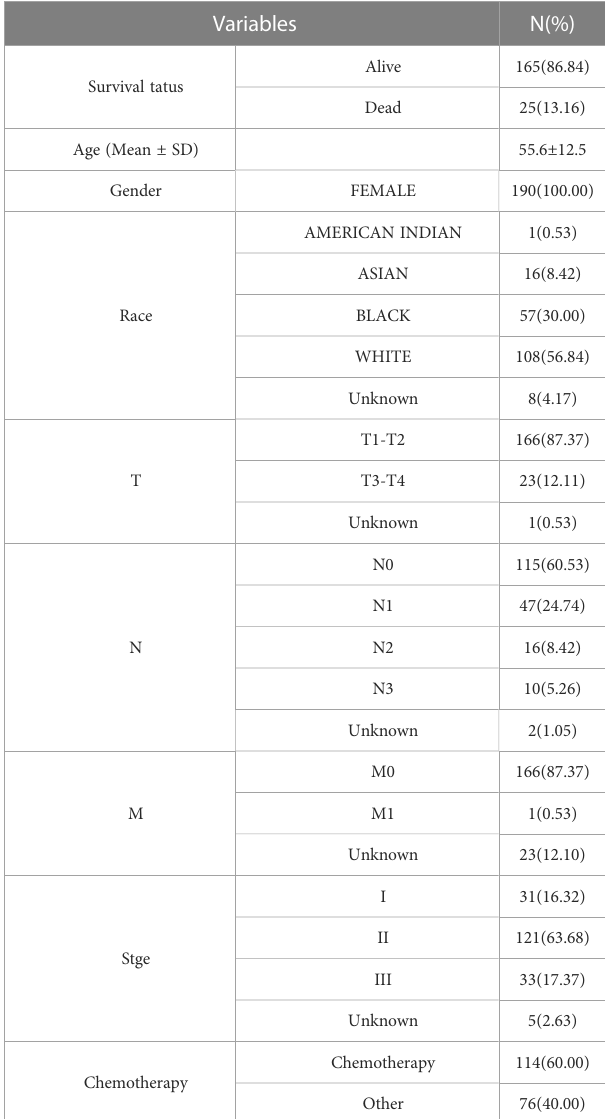
TABLE 1 The baseline clinical characteristics of the TNBC patients from TCGA used in this